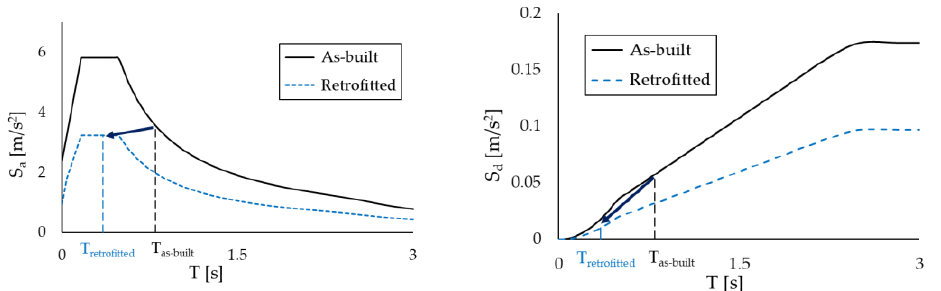
Figure 17. Acceleration and displacement spectra for the RC frame in the as-built and retrofitted configurations, showing the combined effect of structural stiffening introduced by the brace and damping of the PS-LED.